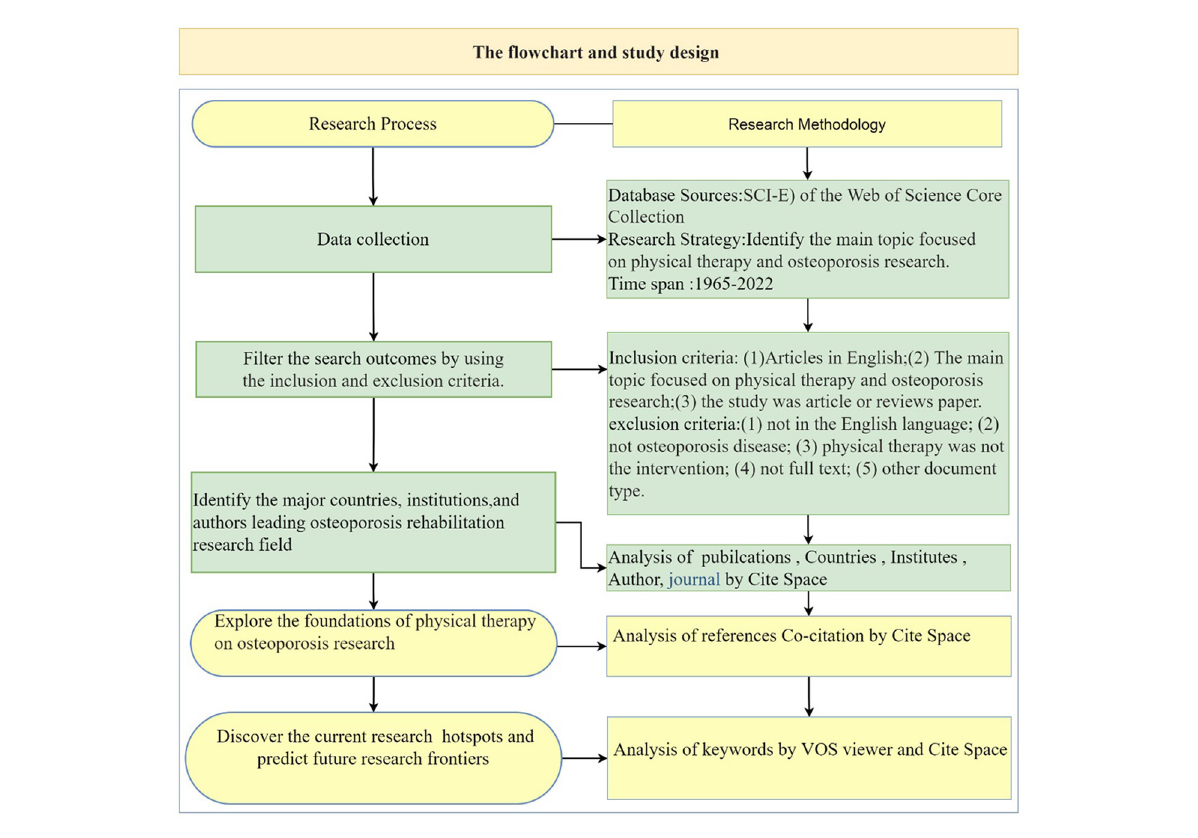
FIGURE1 The summary of the flowchart and study